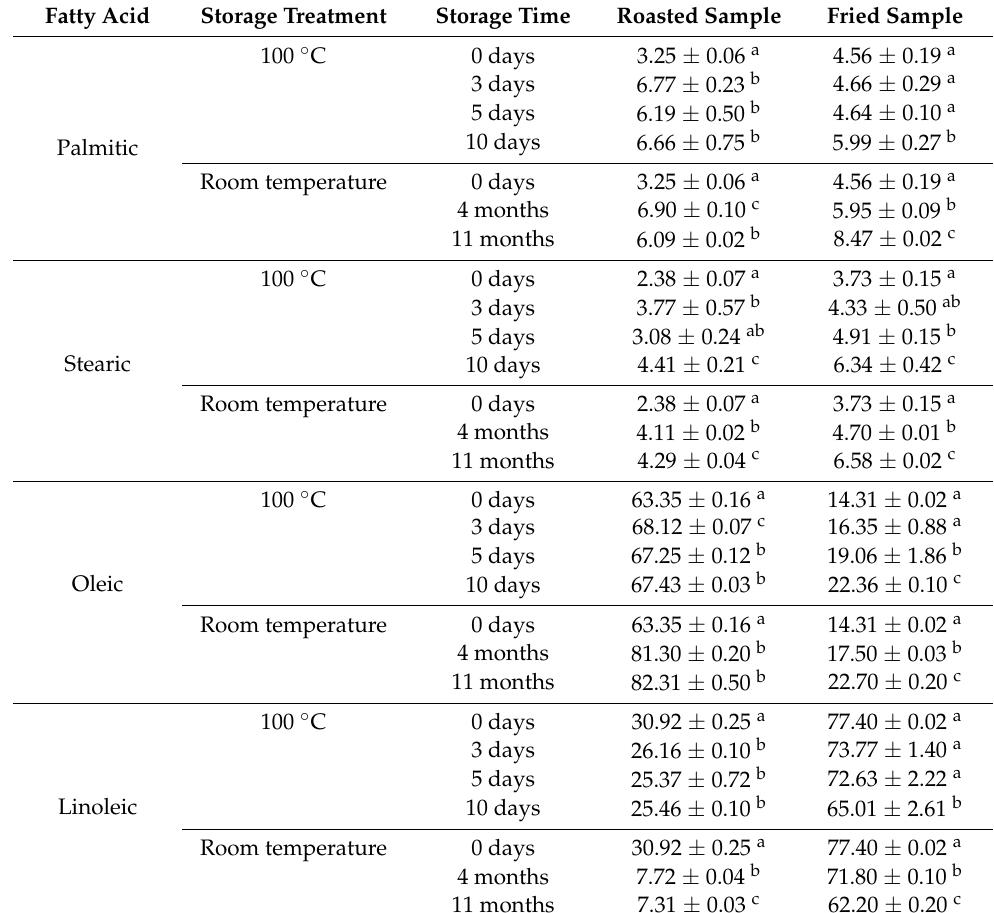
Table 2. Major fatty acid content of sunflower seeds (g fatty acid/100 g seed oil) as a function of storage time for accelerated and room temperature oxidation